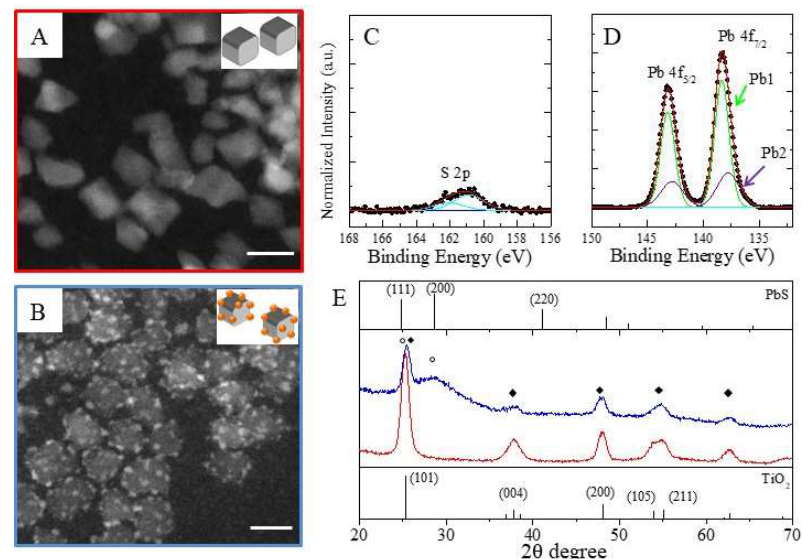
Figure 4. HAADF-STEM images (scale bar 10 nm) of ( A ) TiO 2 seed NCs and ( B ) TiO 2 / PbS hybrid nanostructures. ( C , D ) XPS spectrum of TiO 2 / PbS hybrid NCs in the 130–170 eV range: raw data (scattered plot) and fitting curve of the S 2p (C, light blue line) and of the Pb 4f ( D ), based on two contributions Pb1 (D, green line) and Pb2 (D, violet line). ( E ) XRD spectra of TiO 2 NCs (red line) and TiO 2 / PbS hybrid (blue line) together with the Bragg hkl reflections positions for TiO 2 anatase (bottom markers, crystal system: tetragonal, PDF2-ICDD code: 842186) and PbS (upper panel, crystal system: cubic, PDF2-ICDD code: 00-005-0592) crystal structures. The XRD spectra of the two samples are reported, and shifted for the sake of clarity. Filled square and empty circle symbols are ascribed to TiO 2 anatase and PbS peaks,